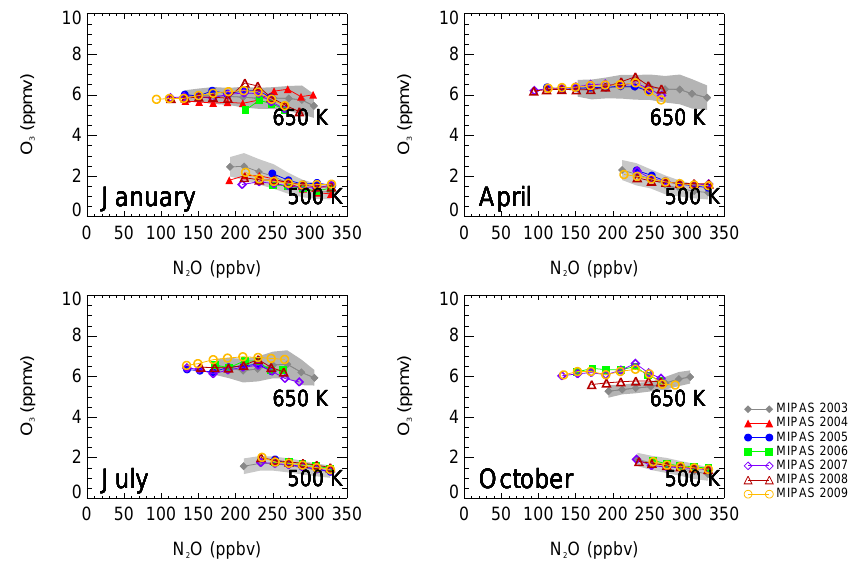
Fig. 5. Same as Fig. 3, but for MIPAS observations for the years 2003–2009: 2003 (grey diamonds), 2004 (red triangles), 2005 (blue circles) and 2006 (green squares), 2007 (violet diamonds), 2008 (dark red triangles), 2009 (gold circles). Note: MIPAS measurements in 2003–2004 were performed with the nominal spectral resolution and from 2005 onwards with reduced spectral resolution.